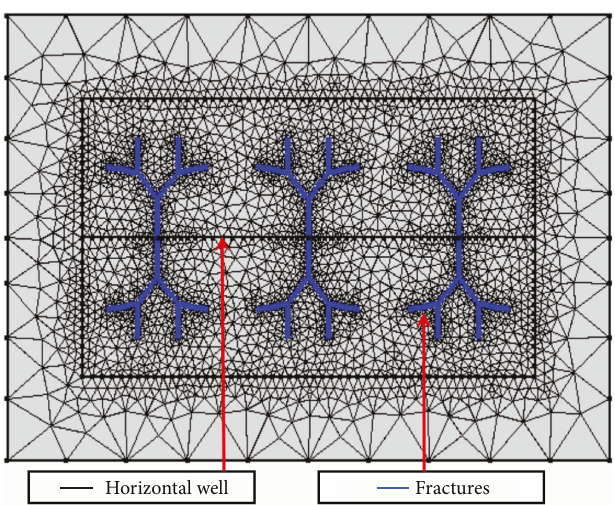
Figure 3: Unstructured triangular mesh grid used in fi nite element numerical computation with the re fi nement around hydraulic fractures and horizontal